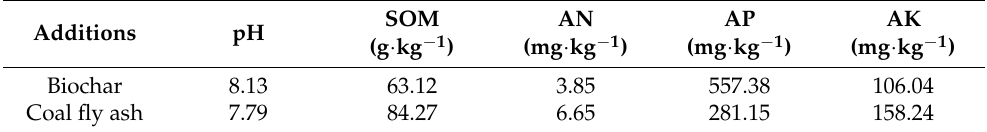
Table A2. Main properties of soil